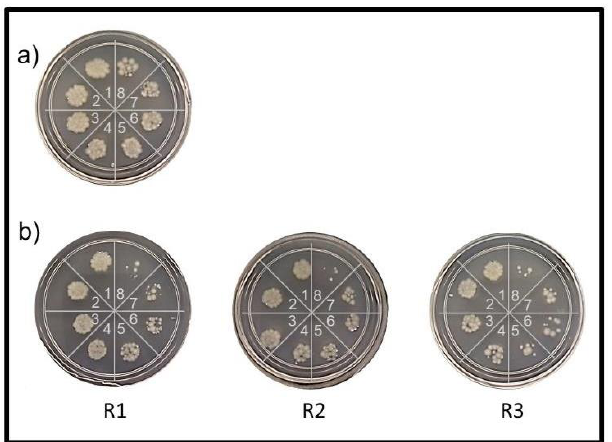
Figure 7. Reusability was tested by repeating 21 min treatment of 10 4 CFU/mL E. coli culture using 5 mg/mL of annealed MS-TiO 2 -10 (8.7 wt.% Ti) nanocomposite under 365 nm UV light. Agar plate results of ( a ) the control without the nanocomposite, and ( b ) the 3 repeated treatment cycles represented by R1, R2 and R3 with the nanocomposite. 1 = untreated, 2, 3, 4, 5, 6, 7, 8 = after 3, 6, 9, 12, 15, 18, 21 min treatments.